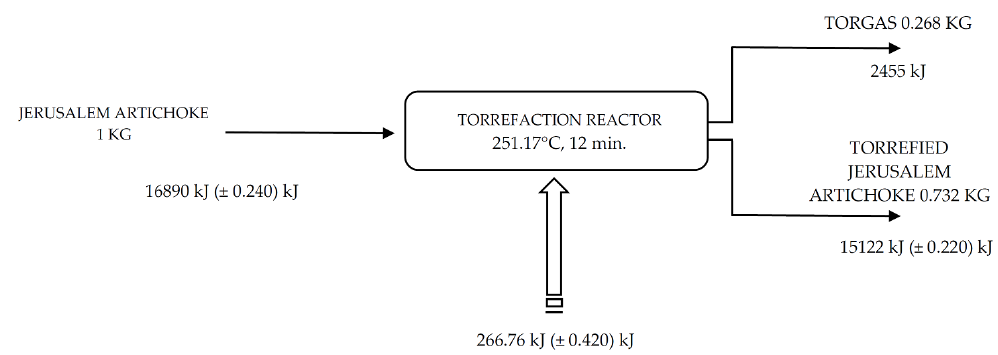
Figure 9. Mass and energy balance of the Jerusalem artichoke torrefaction process ( t = 251.17 °C, 12 min).